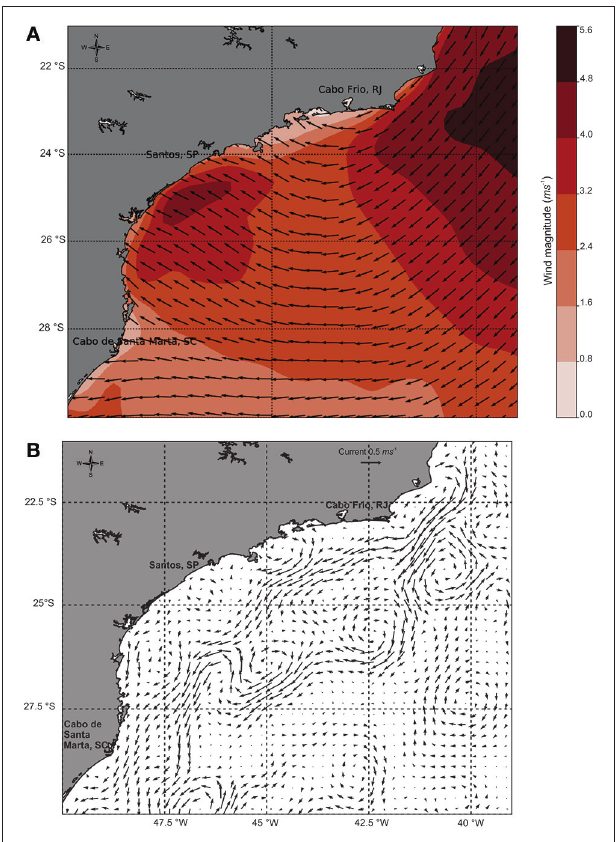
FIGURE 3 | Summer scenario during the sampling period in the South Atlantic Ocean: (A) Wind direction and magnitude (m.s − 1 ), (B) Geostrophic velocity (m.s − 1 ) from daily-mean